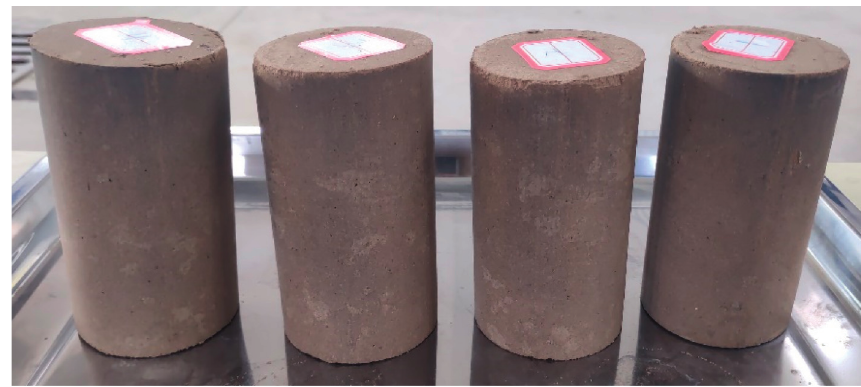
Figure 7: Samples for unconfined compression test.